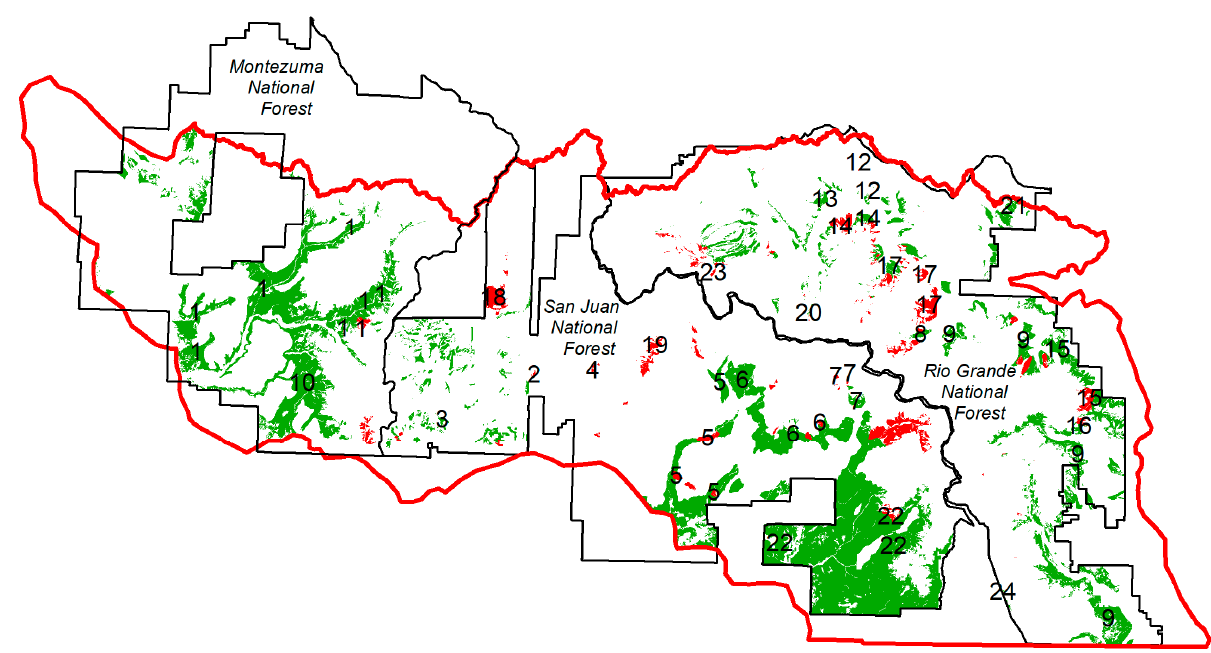
Figure 9. “The three atlas boundaries (black lines) and the fires (red) and woodlands (green) shown on the atlases with the area of ponderosa pine and mixed-conifer forests. Fires were likely mostly stand-replacing, and woodlands likely moderate- to high-severity fires, 1850–1909. Fire and woodland numbers are used in tables and text”. The red boundary is the study area in the southwestern San Juan Mountains, Colorado. Reprinted from ([44] Figure 1b) with permission of MDPI.